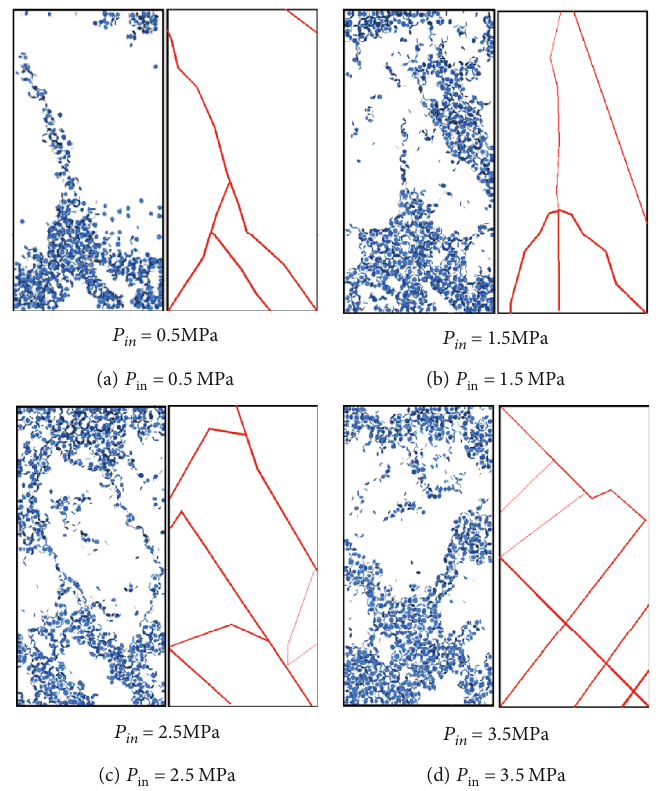
Figure 6: Crack generation of coal measures sandstone under di ff erent seepage